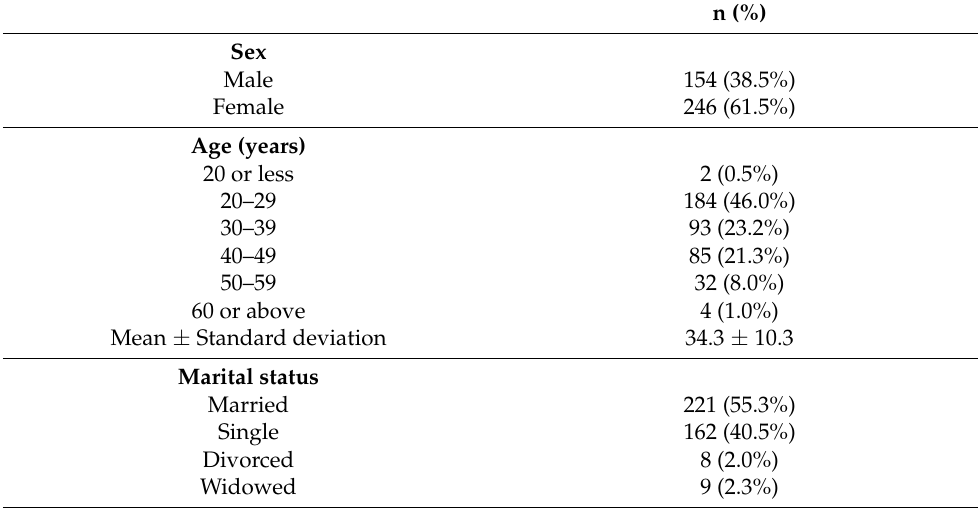
Table 1. Participants’